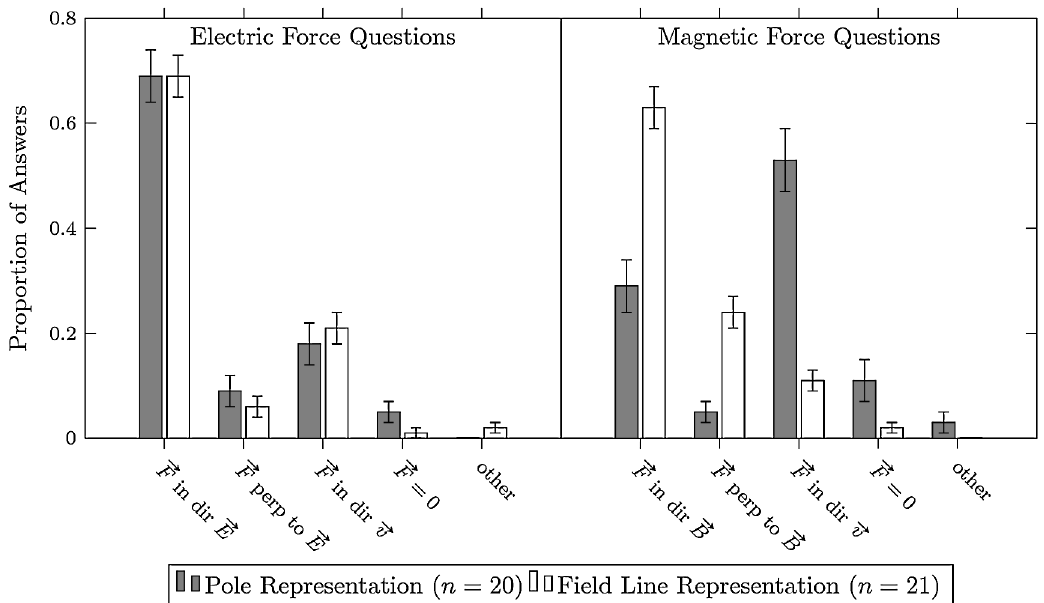
FIG. 3. Student responses to electric and magnetic force questions previous to instruction in both electricity and magnetism.